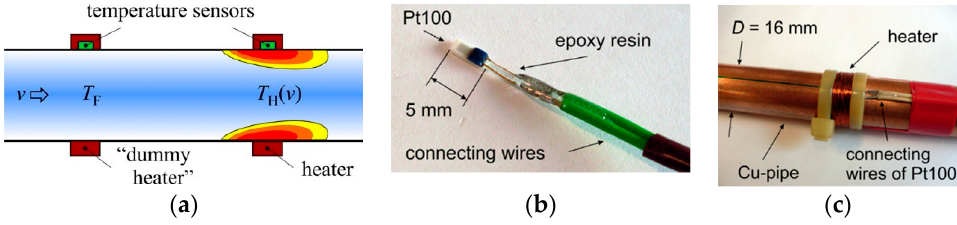
Figure 1. ( a ) Schematic cross section of the sensor; ( b ) Pt100 elements used for the sensor prototype; ( c ) A copper wire (0.2 mm diameter, about 10 m long) was coiled around the downstream Pt100 element serving as a heater. The heater resistance amounts to approximately 11 Ω